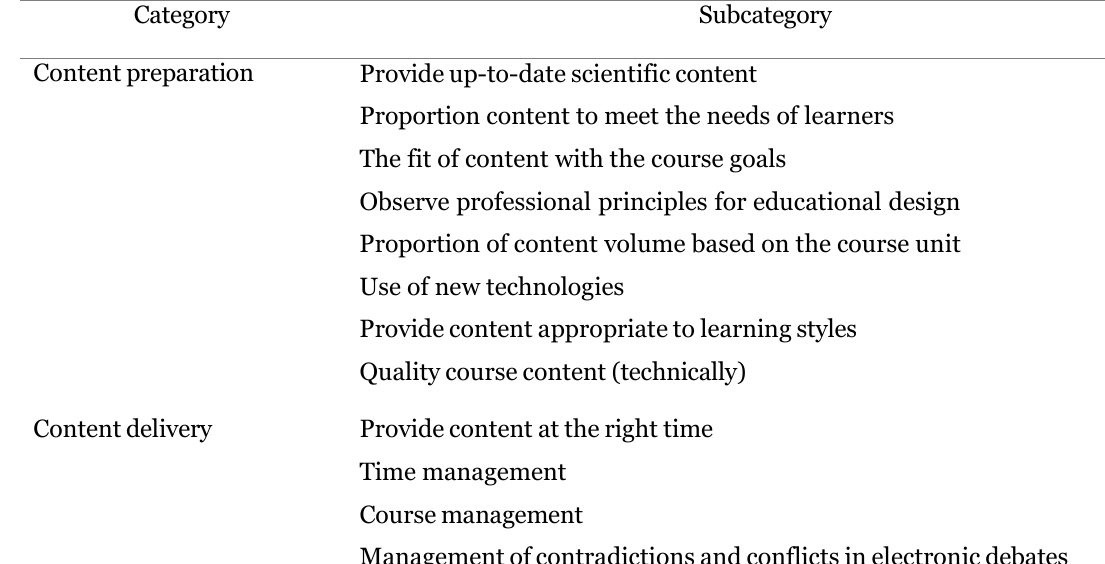
Main and Sub Categories Affecting Peer Observation in LMS-Based Classes in Medical Sciences